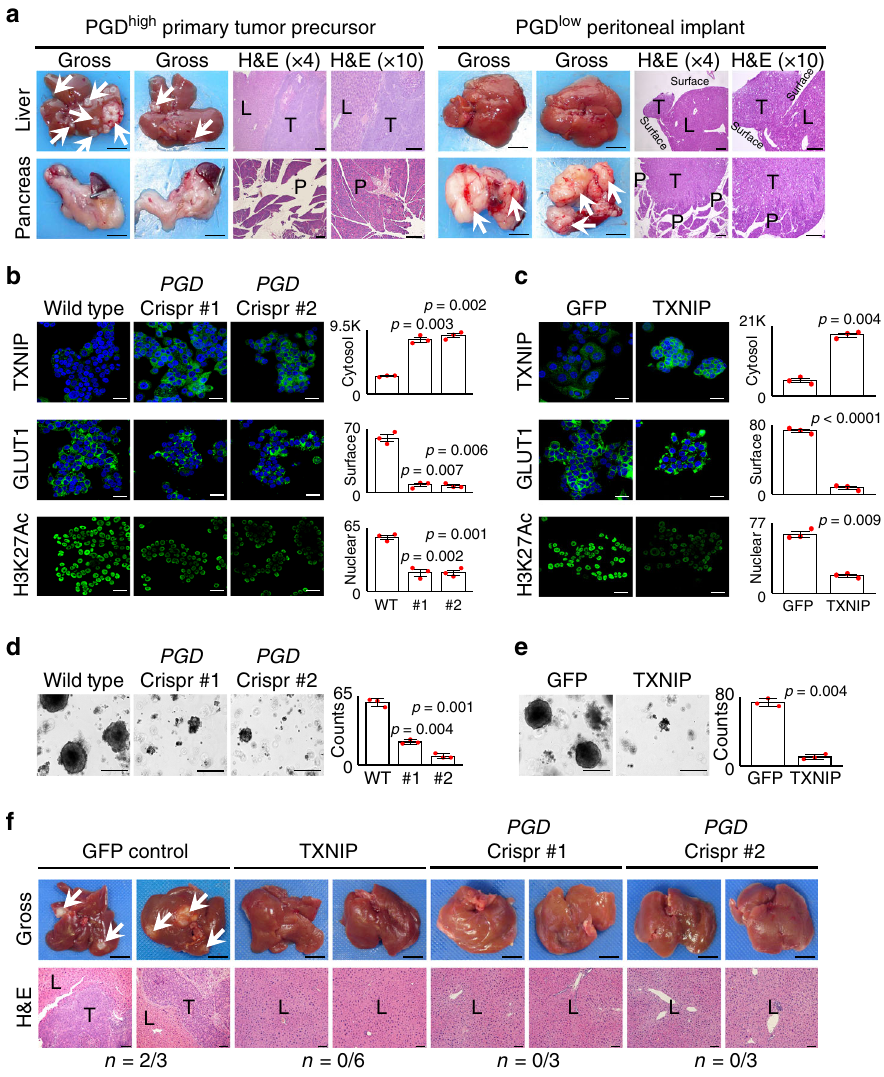
Fig. 7 Experimental metastasis is dependent on PGD and suppression of TXNIP in vivo. a (Left) PGD high 13Pr cells implanted into the spleens of athymic mice preferentially develop liver metastasis (arrows, n = 4/4) without involvement of the pancreatic parenchyma ( n = 0/4), as shown by representative gross photographs and H&E-stained sections. (Right) In contrast, PGD low 38Per cells formed grossly evident pancreatic tumors ( n = 5/5), with small tumor implants on the outside surface of the liver as seen on H&E-stained sections ( n = 3/5). Gross photograph scale bars: 1 cm, H&E scale bars: 400 µ m. L liver, P pancreas, T tumor. b , c Engineering 13Pr cells with PGD Crispr/Cas sgRNAs ( b ) or exogenous TXNIP ( c ) reversed TXNIP suppression (top), surface GLUT1 retention (middle), and H3K27 hyperacetylation (bottom) by confocal IF ( n = 3 biological replicates, error bars: s.e.m., indicated p values calculated by two-tailed t tests, scale bars: 20 µ m). d , e 13Pr cells engineered with Crispr/Cas PGD inactivating sgRNAs ( d ) or exogenous TXNIP ( e ) impaired 3D in vitro tumoroid growth relative to 13Pr control cells ( n = 3 technical replicates, error bars: s.d.m., indicated p values calculated by two-tailed t tests, scale bars: 400 µ m). f Representative gross and H&E-stained sections demonstrate that 13Pr cells engineered with exogenous TXNIP ( n = 0/6) or Crispr/Cas inactivation of PGD ( n = 0/6) failed to develop liver metastases compared to 13Pr control cells ( n = 2/3). Gross photograph scale bars: 1 cm, H&E scale bars: 400 µ m. L liver parenchyma, T